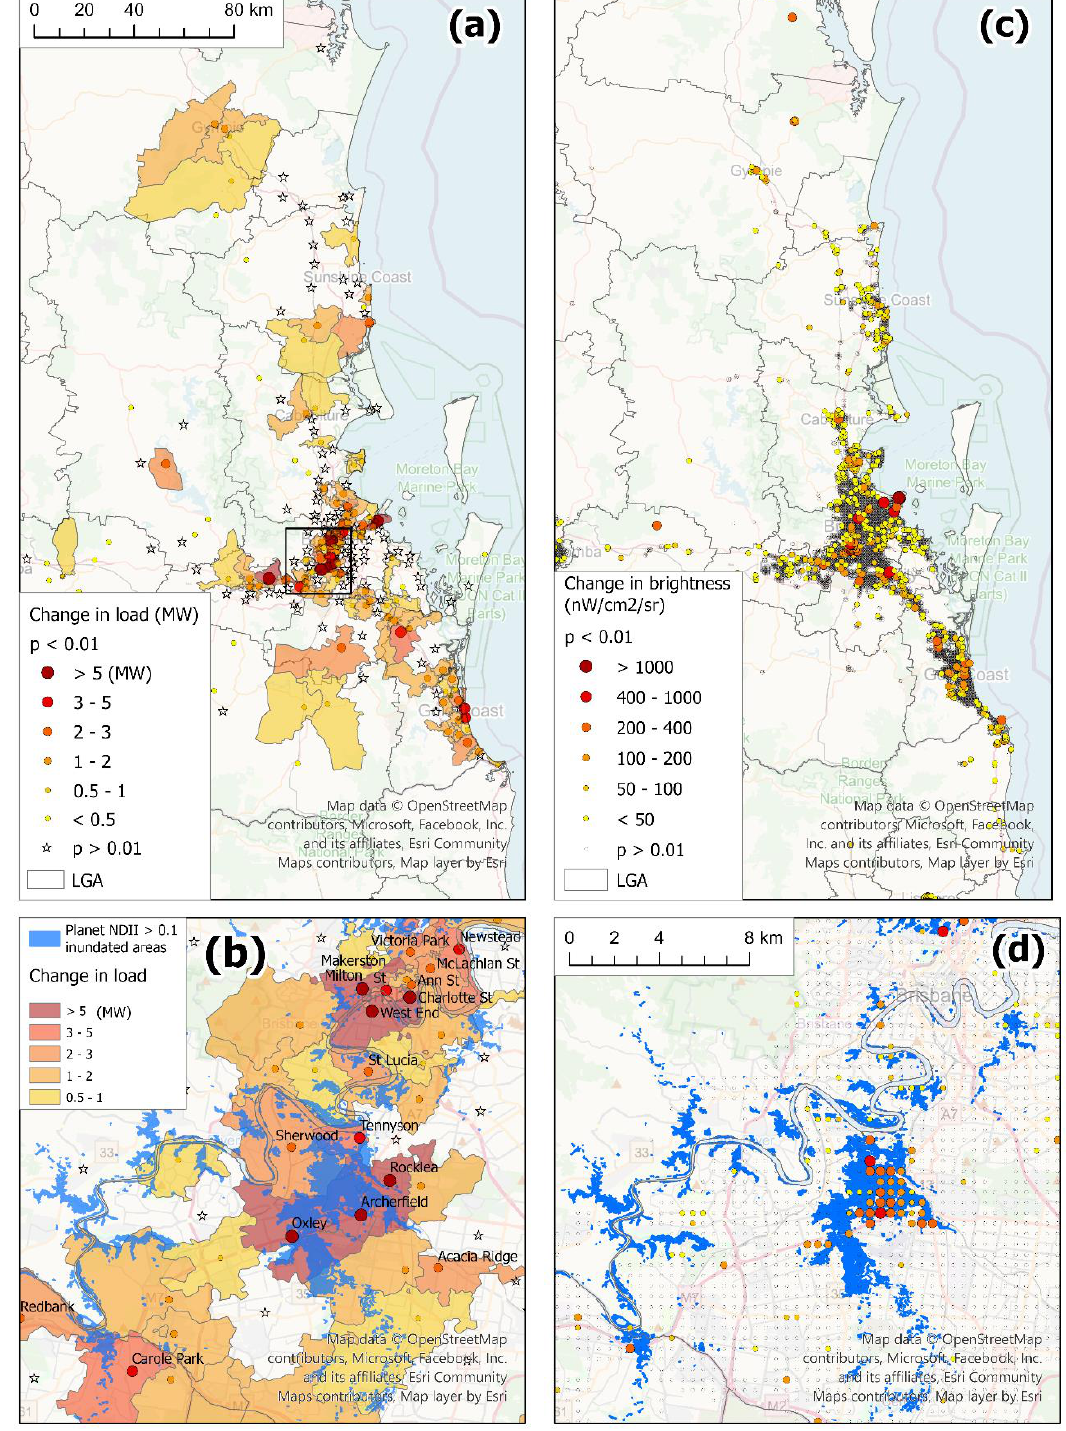
Figure 9. The impact of floods on electricity loads (based on Energex data for substation zones; ( a , b )) and on nighttime brightness (from VIIRS nightly data; ( c , d )), comparing pre-flood period values and during flood period values (periods defined in the Methods). All changes shown indicate a decrease in energy use due to the impacts of the floods. In both datasets, only changes where the statistical significance of the t -test was below 0.01 are shown. The inset maps zooming on Brisbane ( b , d ) also show the inundated areas based on the PlanetScope image.